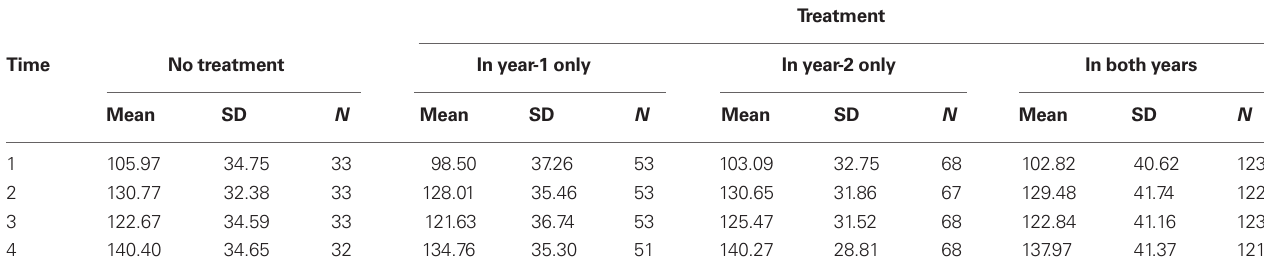
Table 3 | Descriptive statistics – two schools